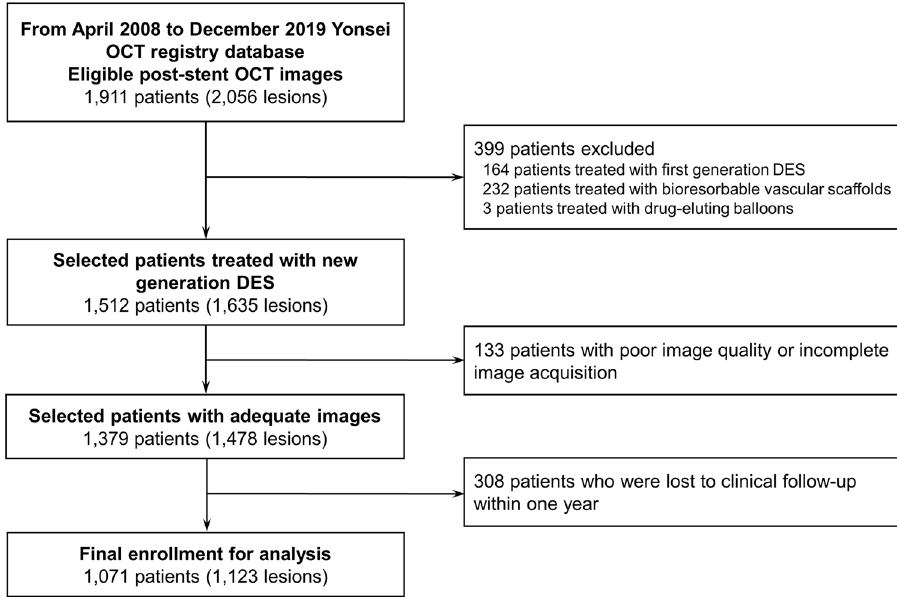
Figure 1. Study flow. Study population at each step and reasons for exclusion are described in detail. DES drug eluting stent, OCT optical coherence